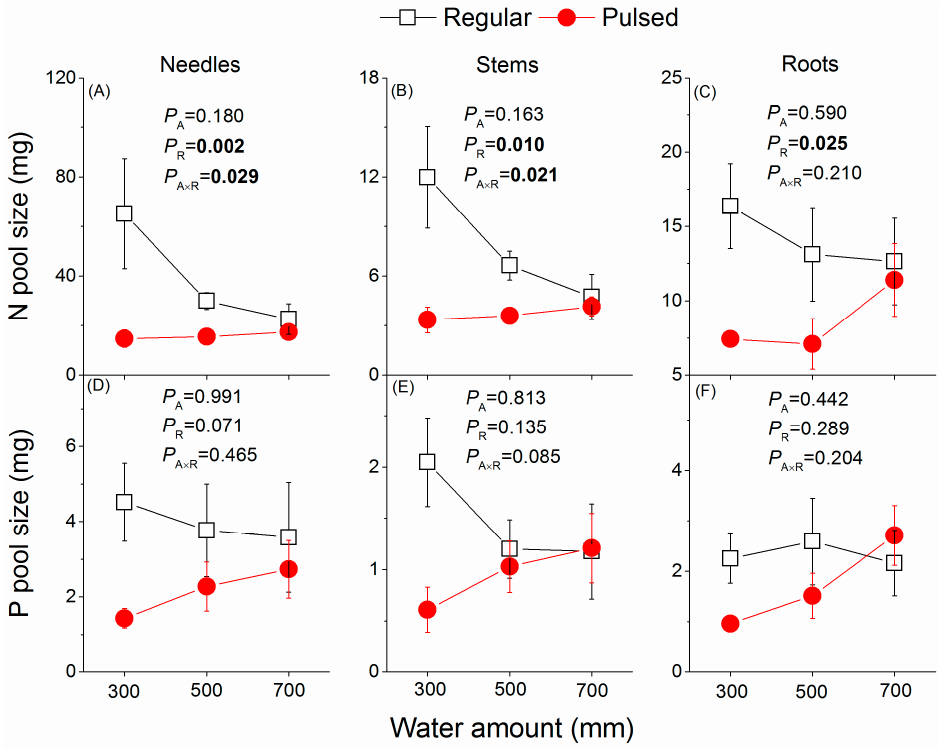
Figure 7. Effects of the watering regime (regular vs. pulsed) and water amount (300, 500, and 700 mm) on pool size of N ( A – C ) and P ( D – F ) in different tissues of P. massoniana saplings. p values of two-way ANOVAS are given. A and R represent water amount and watering regime, respectively. Plotted are means ± SE.